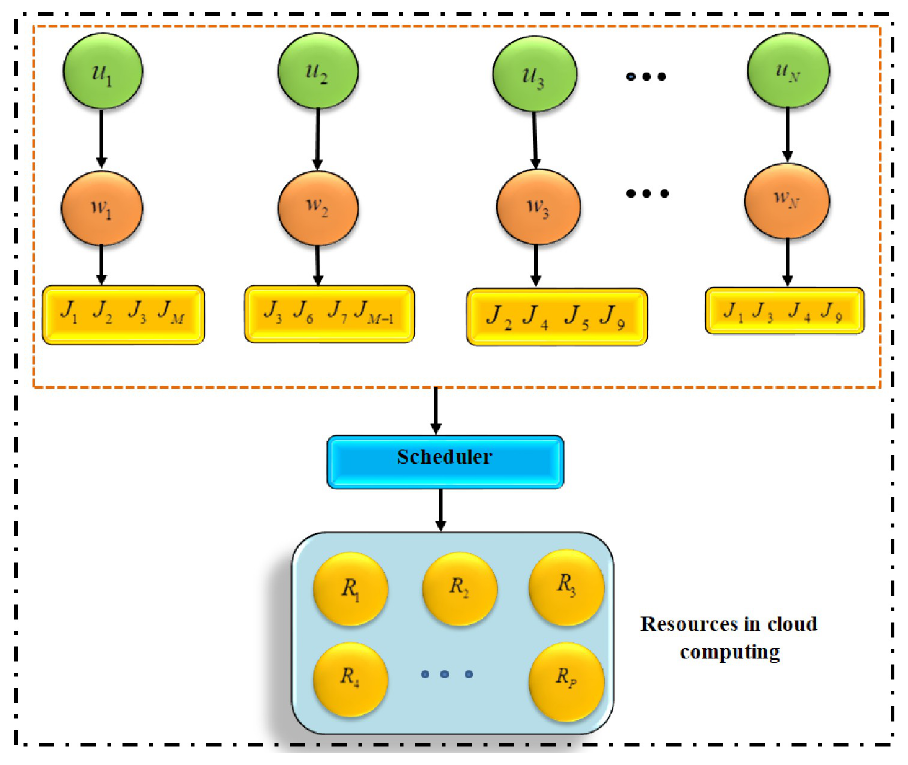
Fig 1. Architecture of job scheduling in